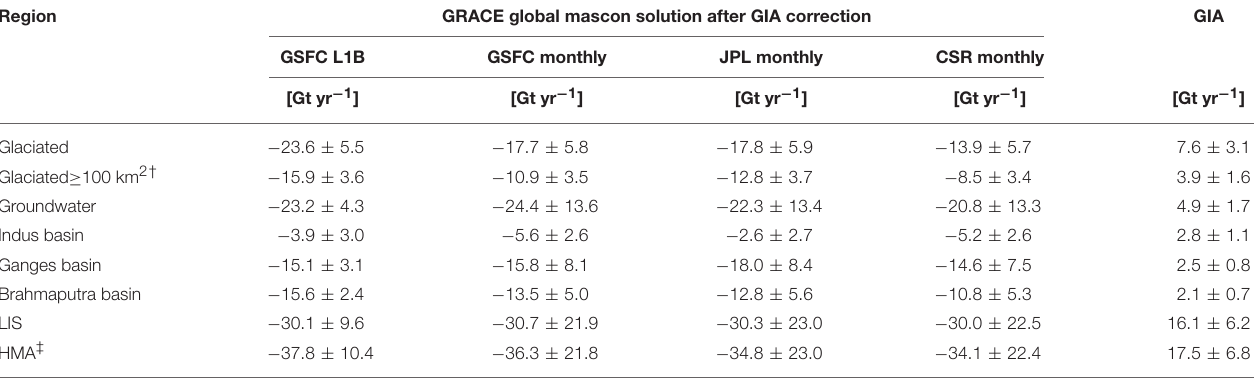
TABLE 1 | GRACE regional mass trends and uncertainties (Gt yr − 1 ) for different mascon solutions over the span January 2003–July 2016, along with the applied GIA correction for each region.